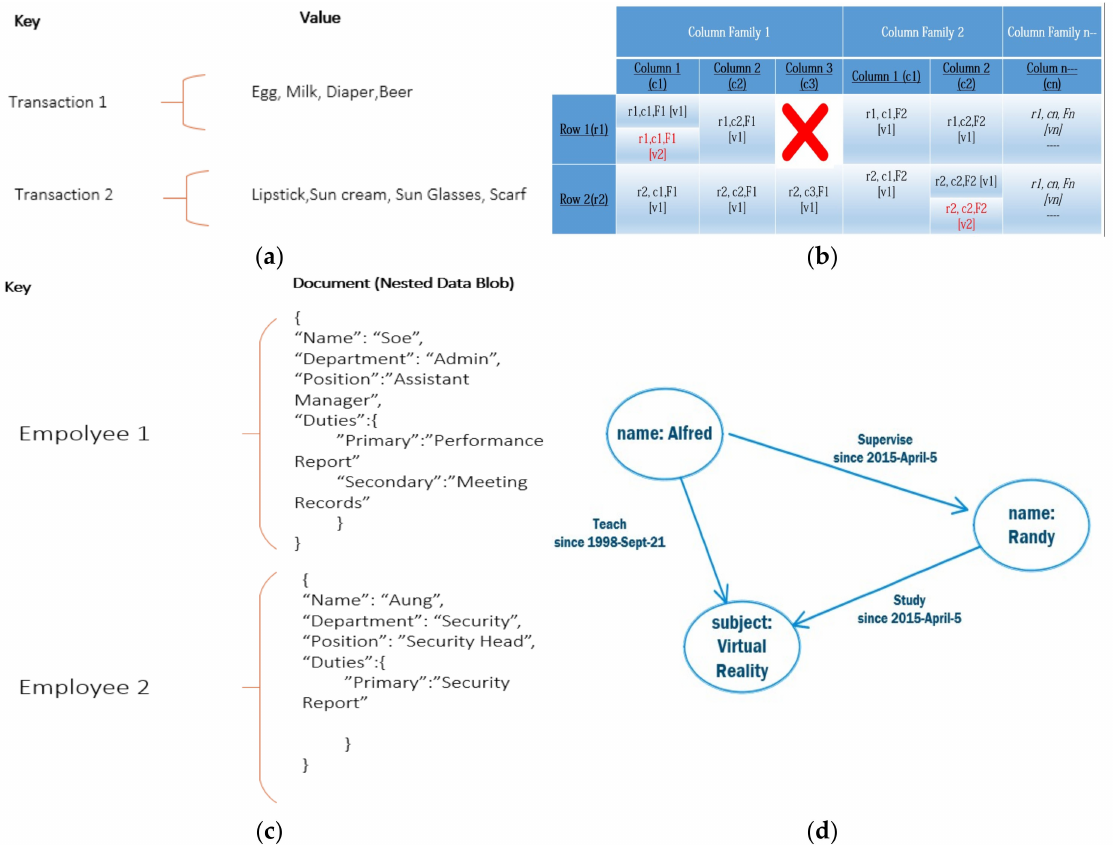
Figure 2. Types of NoSQL data stores. ( a ) Key-Value Store; ( b ) Columnar Store; ( c ) Document Store; ( d ) Graph